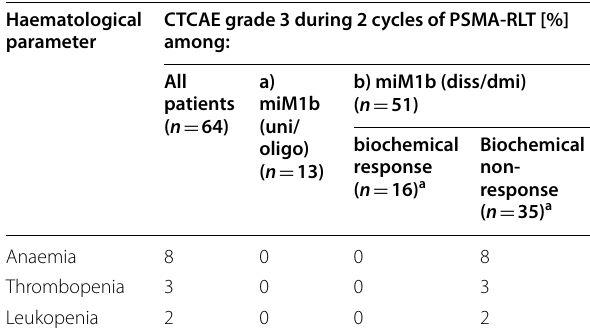
64) and different =